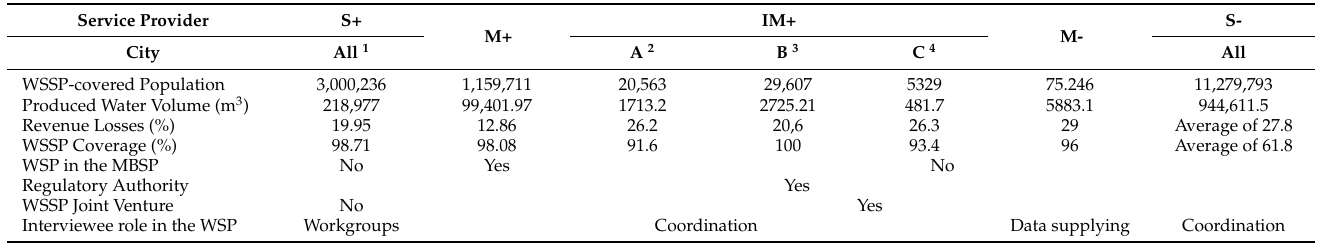
Table 3. Characteristics of the five public water supply service providers (WSSP) who have imple- mented WSPs and were interviewed [3,24].